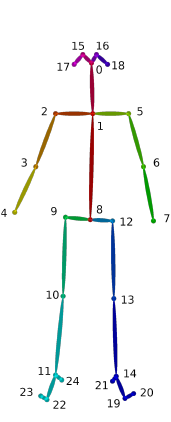
Figure 2. OpenPose body-foot keypoint